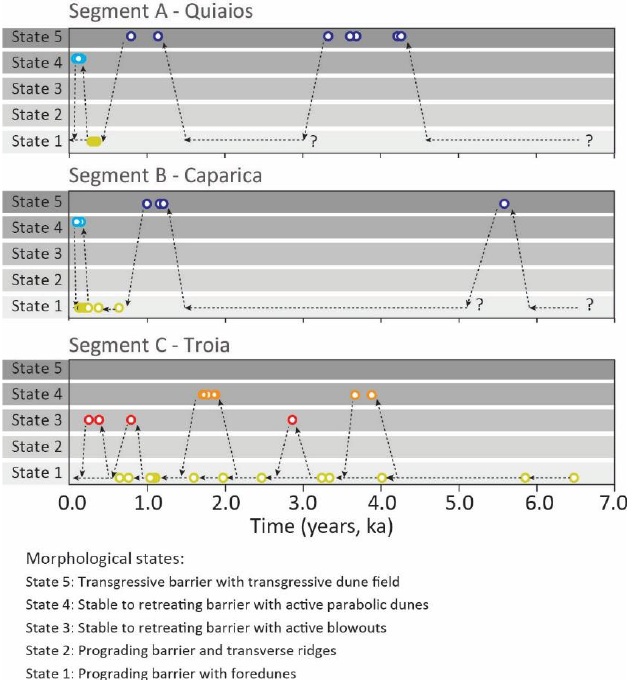
Figure 8. Evolutionary trajectories were reconstructed for each of the three selected study sites. System trajectories result from shifts between morphological states over time. The age of the onset of the different states over time results from the compilation of information from the three selected sites available in [16 – 18].